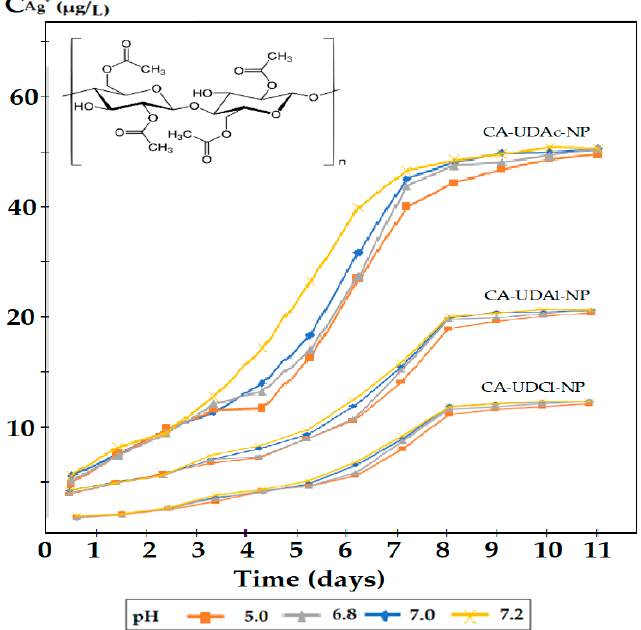
Figure 6. Concentration of silver ions released in the receiving aqueous phase of pH: 5.0, 6.8, 7.0 and 7.2 for cellulose acetate membrane in the case of 10–undecenoic acid (UDAc), 10–undecen–1–ol (UDAl) or 10–undecenoic chloride (UDACl) as dispersants and oxide nanoparticles with 1.63% silver. The amount of silver ions released into the environment depends on both the poly- meric matrix and the three dispersants used (Figures 6 and 7). The cellulose acetate matrix (Figure 6) released the silver ions harder than the polysulphone matrix (Figure 7), most likely due to the interaction of silver ions with the acetyl and hydroxyl groups in cellu- lose